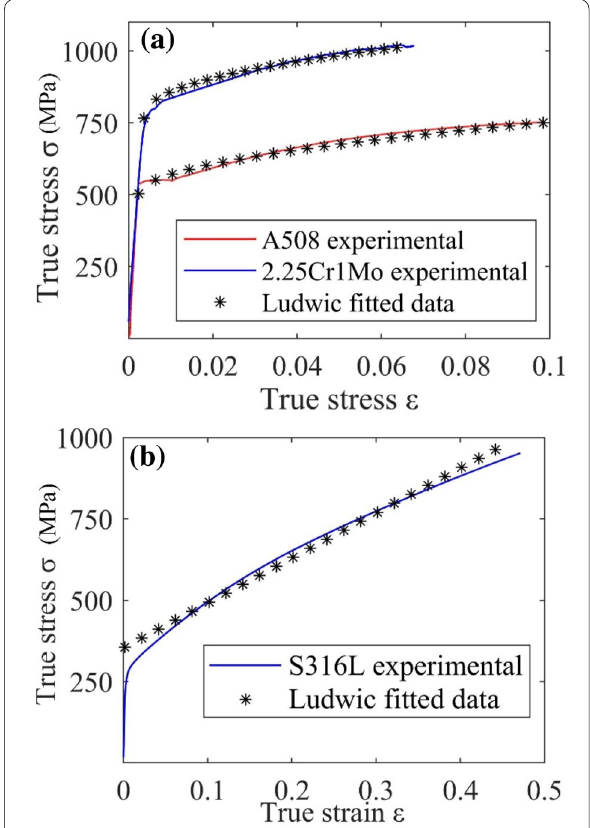
Figure 5 True stress strain curves extracted from uniaxial tensile tests: ( a ) A508 and 2.25Cr1Mo; ( b ) S316L